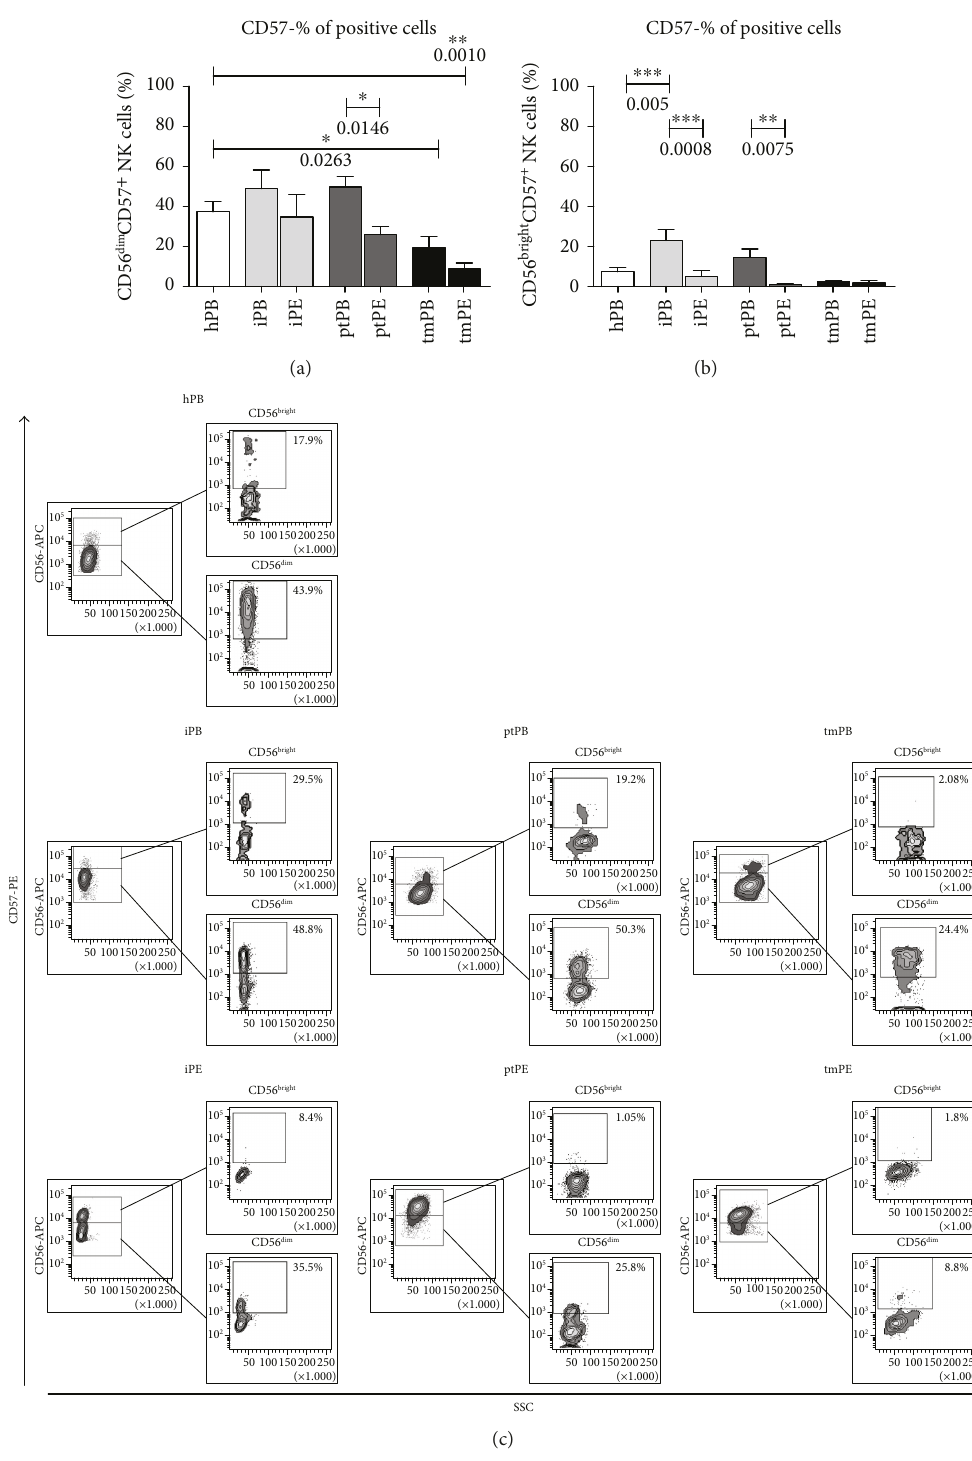
Figure 3: CD57 expression on NK cell subsets. Flow cytometric analysis on NK cell subsets from healthy individuals (hPB), peripheral blood (iPB) and pleural e ff usion (iPE) from patients with in fl ammatory disease, peripheral blood (ptPB) and pleural e ff usion (ptPE) from patients with primary tumor and peripheral blood (tmPB), and pleural e ff usion (tmPE) from patients with tumor metastasis revealed a decrease percentage of mature NK cells correlated to the downregulation of CD57 marker in PE samples as compared with PB and healthy donors. The percent of CD57 expression was even lower in the CD56 bright NK cell subsets, con fi rming the acquisition of a more immature phenotype (a, b). Representative dot plots of CD57 distribution in CD56 bright and CD56 dim NK cell subsets (c) in healthy donors and patients with in fl ammatory, primary, and metastatic tumor PE are shown, respectively. Data are shown as mean ± SEM 39 samples were analyzed; ∗ p < 0 05 , ∗∗ p < 0 01 , and ∗∗∗ p < 0 001 ( p values are